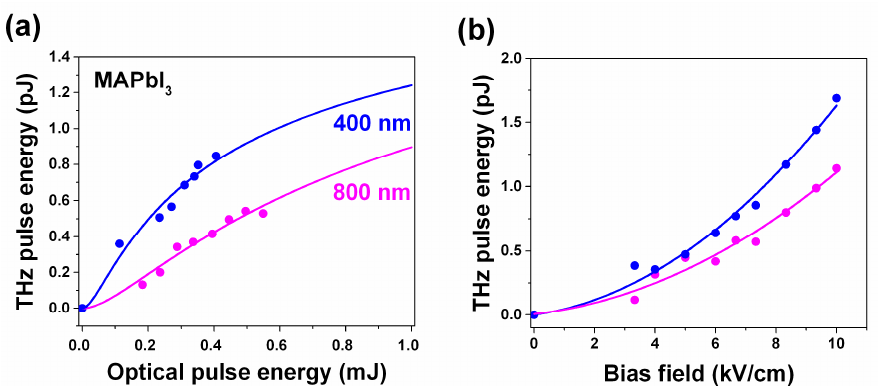
Figure 7. The MAPbI 3 -based HP-LAPCA terahertz pulse energy as a function of the optical excitation energy ( a ) and applied bias voltage ( b ) for pumping above (400 nm, blue) and below (800 nm, magenta) the bandgap.